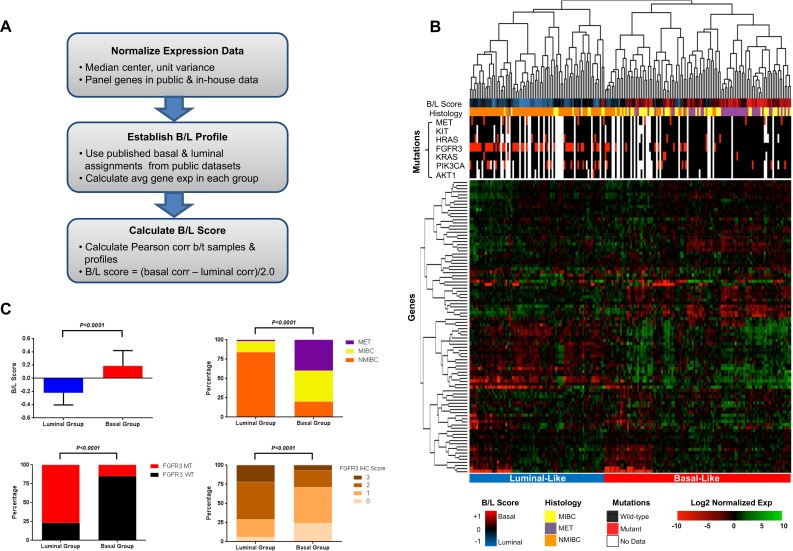
Molecular characterization of a novel cohort of FFPE tissues using the bladder cancer panel.(A) Methodology used for computing basal/luminal signatures from public data and then applying these signatures to bladder panel data to determine basal/luminal similarity of samples from a novel clinical cohort. (B) Hierarchical clustering (average-linkage, 1 –Pearson correlation distance metric) of 204 FFPE samples based on bladder cancer panel gene expression and corresponding B/L scores, histology, and mutational status of cancer-relevant genes. (C) Statistical analysis of the B/L scores (top left panel), distribution of NMIBCs, MIBCs, and METs (top right panel), prevalence of FGFR3 mutations (bottom left), and FGFR3 IHC scores (bottom right) in samples from the transcriptionally-defined luminal- and basal-like clusters in Fig 3B.